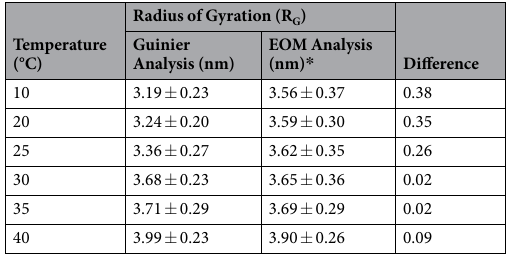
Table 2. A comparison of the radius of gyration (R G ) values computed for the predominant scattering species in the samples of gelsolin protein at different temperatures as determined from Guinier approximation and ensemble optimization method (EOM) are tabulated below. * EOM computes values in Å, and they are converted into nm for comparison. The average and standard deviation values were computed from the output for individual